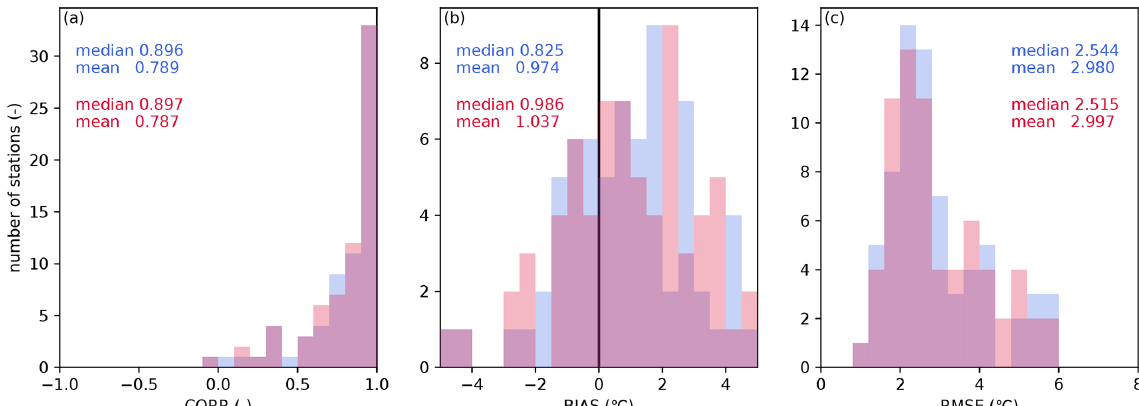
Figure 6. Comparison between reproducibility indices of river temperature. Bars show the histogram of each index, and the numbers indicate associated median and mean values. Blue (red) bars and written values show the result of the coupled (river-only) simulation. Panel (a) shows CORR, panel (b) shows BIAS ( ◦ C), and panel (c) shows RMSE ( ◦ C).